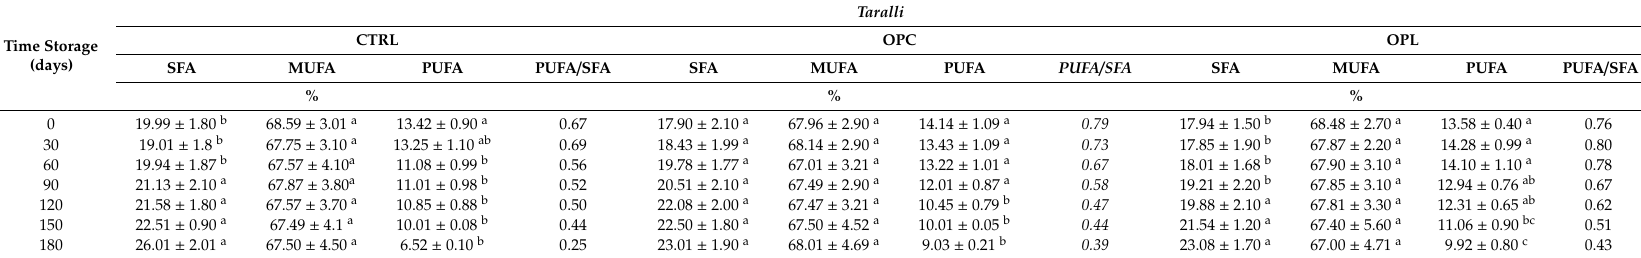
Data are the mean ± standard deviation of three independent replicates ( n = 3). Data were submitted to one-way analysis of variance (ANOVA), Tukey’s test was applied to compare the experimental times (0, 30, 60, 90, 120, 150, 180 days) within the same sample for each classification of fatty acids (SFA, MUFA, and PUFA). Di ff erent letters mean significant di ff erence at p <